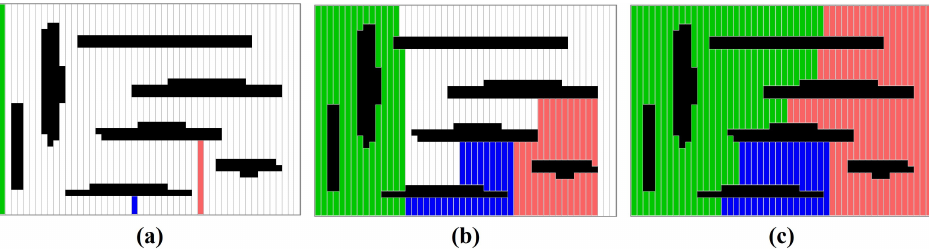
Figure 6. An example of the initial partition for three robots. ( a ) The seeds of three partitions. ( b ) Every partition grows around its seed. ( c ) The initial